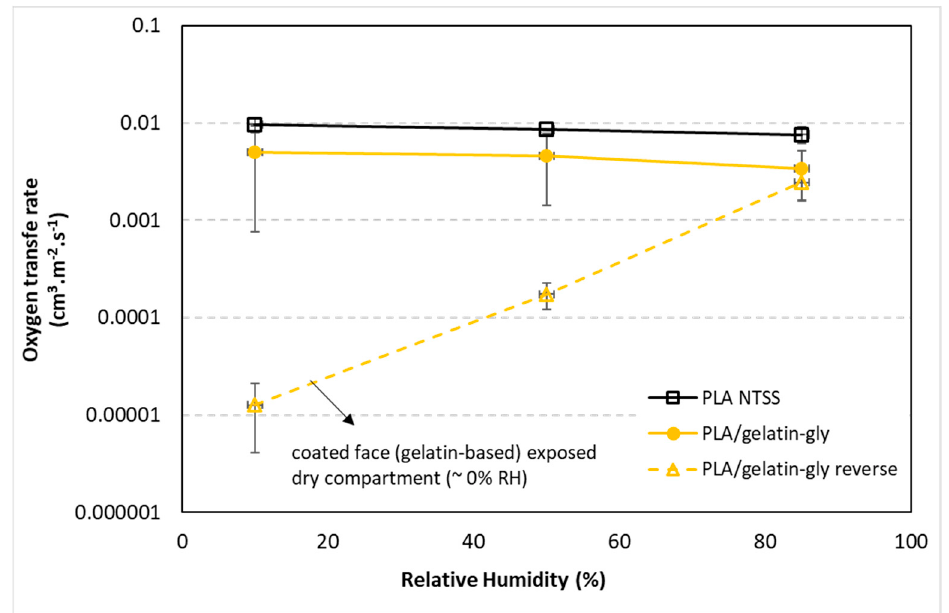
Figure 11. Influence of relative humidity and exposed coated side on oxygen transfer of coated and uncoated PLA-based films. uncoated PLA-based